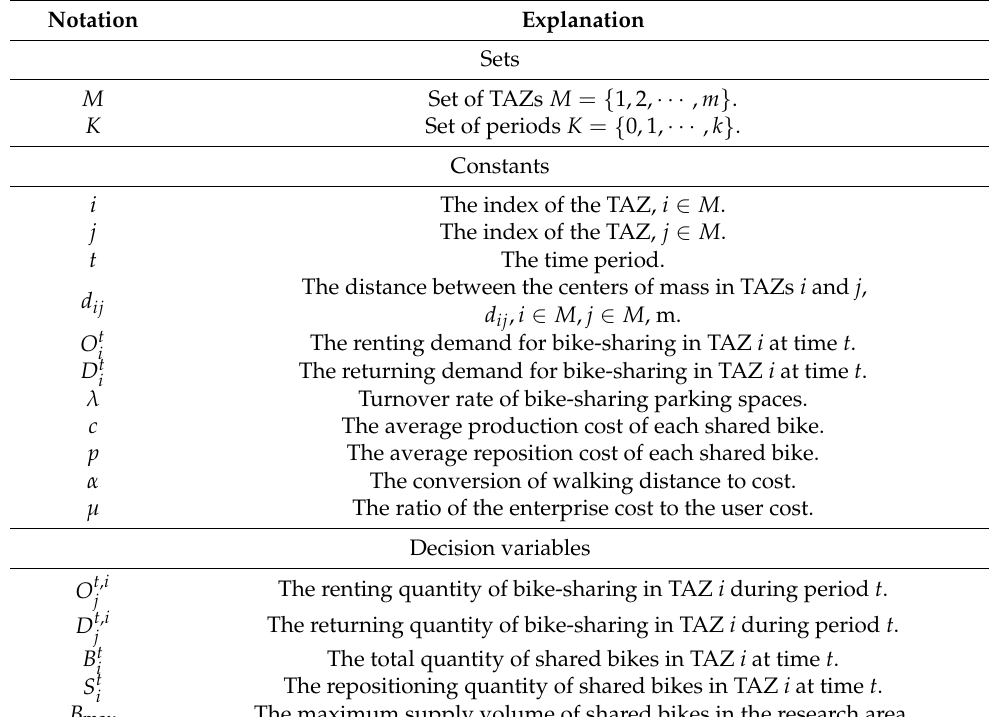
Table 1. Explanation of